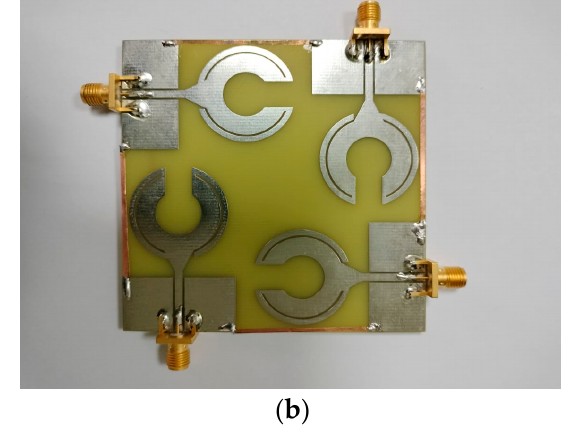
Figure 5. MIMO antenna shown in ( a ), fabricated 2 × 2 antenna array prototype shown in ( b ).